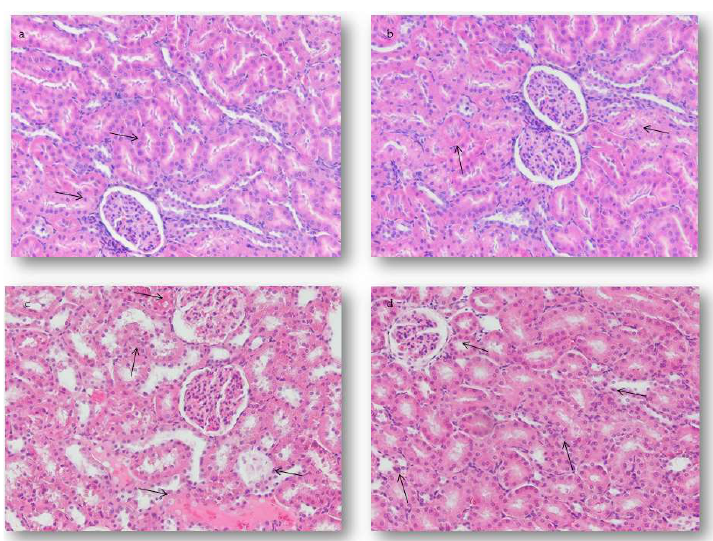
Figure 6. Light micrographs of the renal lesions of rats 28 days after receiving last treatment. H&E stain, magnification 200×. ( a ) Normal histological structure of the renal tissue marked with arrow. ( b ) The AMI-treated group, mild oedema in the renal epithelial cells marked with arrow. ( c ) The DOX-treated group, extensive vascular and degenerative changes in the renal tissue associated with atrophy of some glomeruli marked with arrow. ( d ) The AMI + DOX-treated group, normal glomeruli, and mild PMNCs infiltration of the renal cortex and medulla marked with arrow.